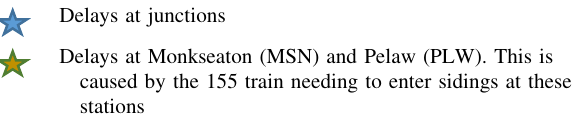
Table 4 Potential causes of the high average delays for Train 155 Delays at